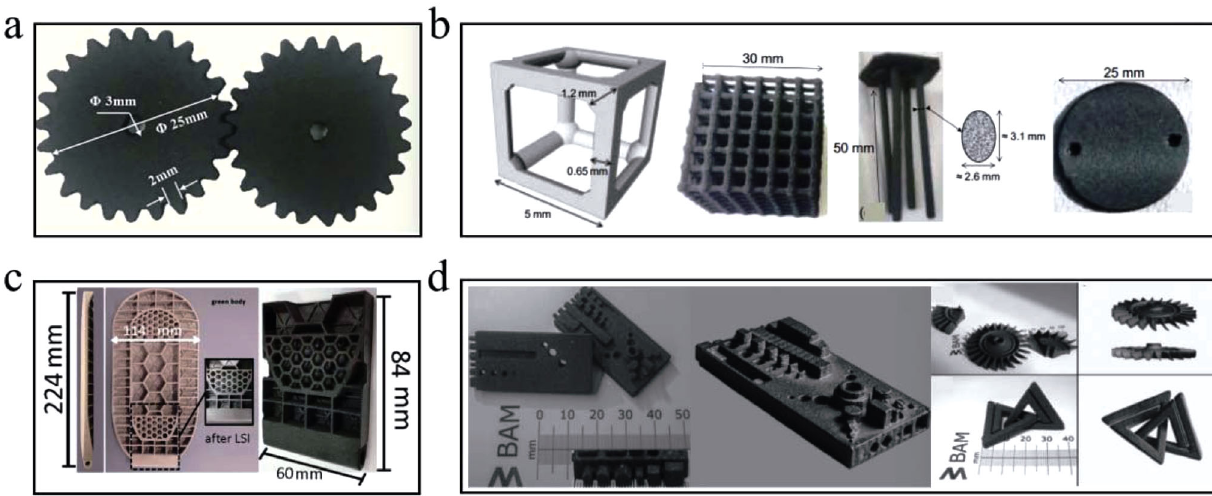
Fig. 14 BJ of SiC ceramic: (a) BJ combined with CVI. Reproduced with permission from Ref. [56], © Elsevier Ltd. 2019. (b) BJ combined with CVI and CVD. Reproduced with permission from Ref. [57], © Elsevier Ltd. 2020. (c) BJ combined with PRBI and CLSI. Reproduced with permission from Ref. [58], © Elsevier Ltd and Techna Group S.r.l. 2019. (d) LSD combined with BJ. Reproduced with permission from Ref. [59], © Elsevier Ltd.